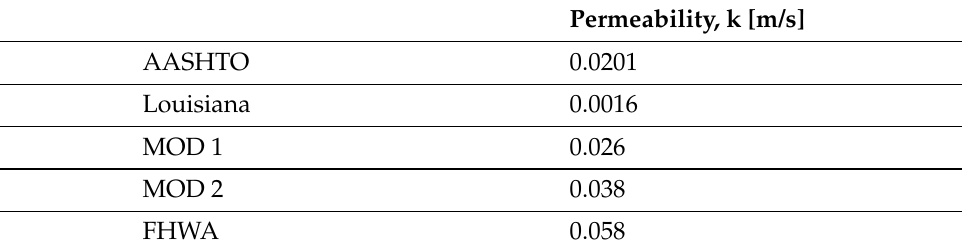
Figure 9. Spanish permeable subbase requirements in comparison to traditional subbase material used in DK—similar to Fuller curve [28,55]. Table 3. Hydraulic permeability coefficient, K, for some of the gradation curves from Figure